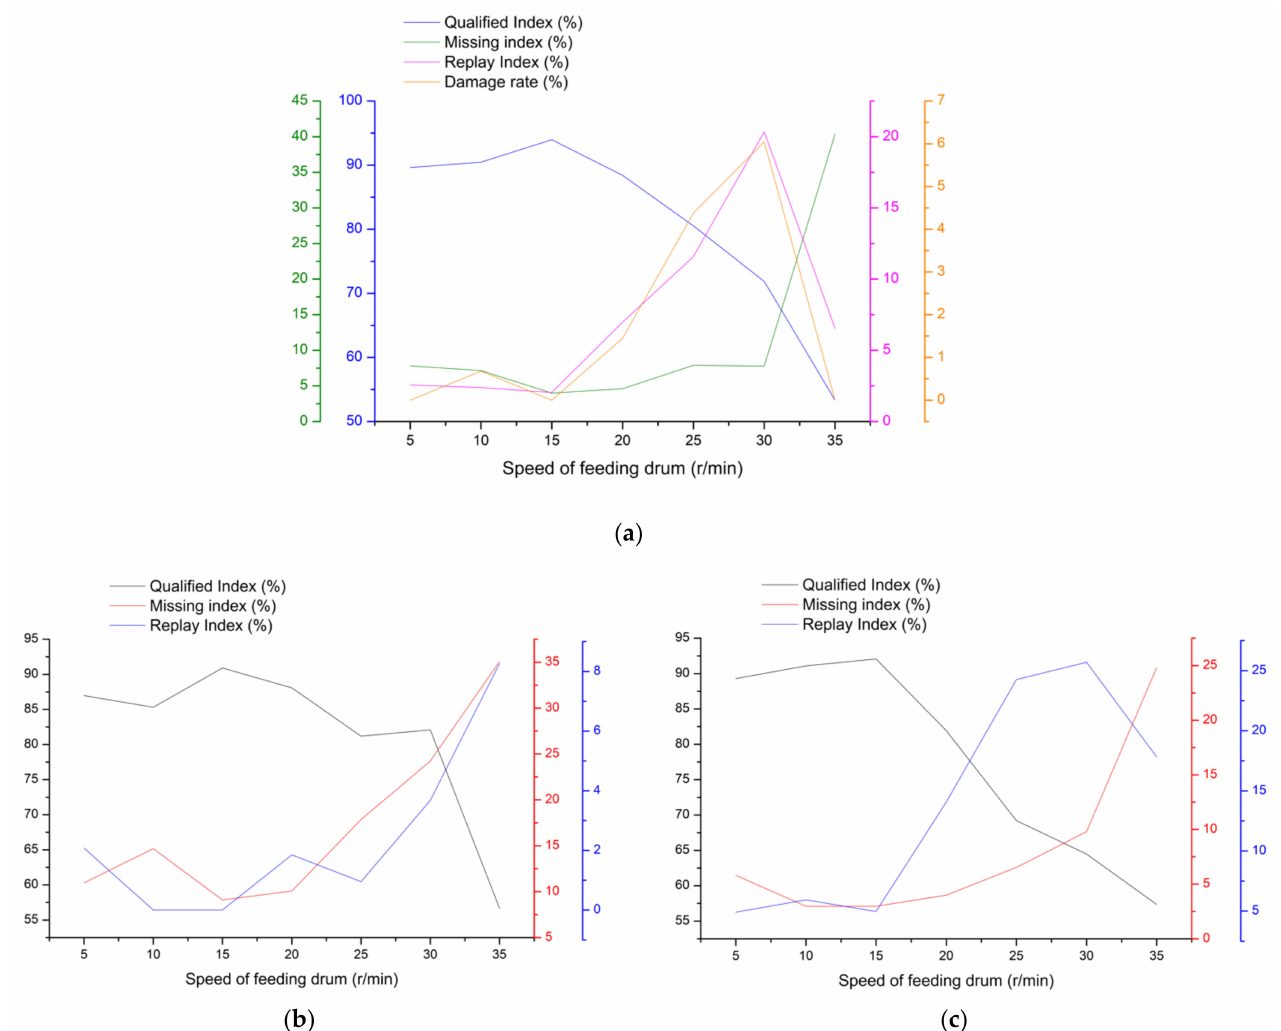
Figure 9. The relation curve between speed of the feeding drum and seed performance ( a ) Soybean; ( b ) Corn; ( c ) Rape.